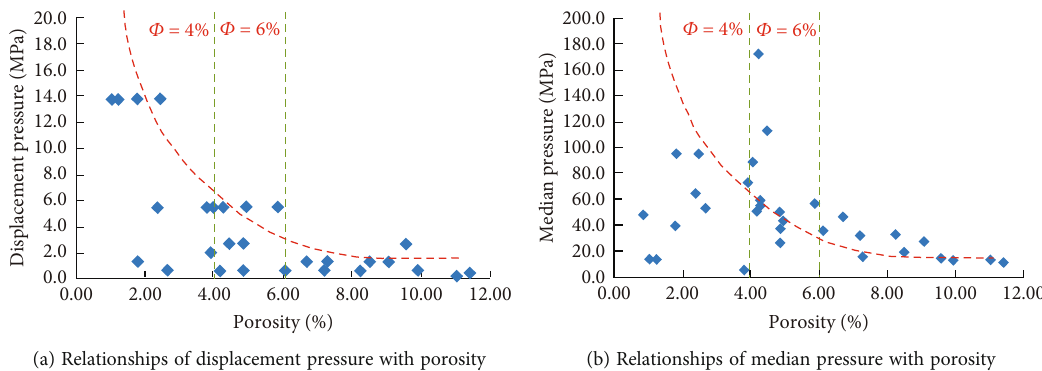
Figure 5: Relationships of displacement pressure and median pressure with porosity. ((a) Relationships of displacement pressure with porosity. (b) Relationships of median pressure with porosity.).